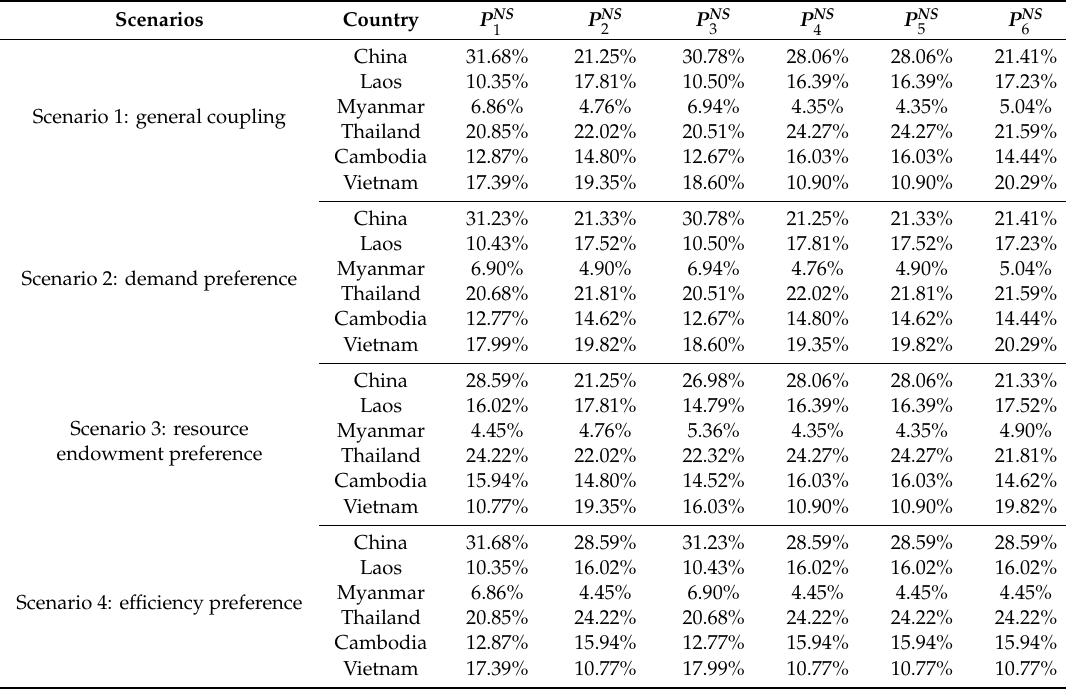
Table 5. Negotiation scheme (NS) of each BC under di ff erent preference scenarios.